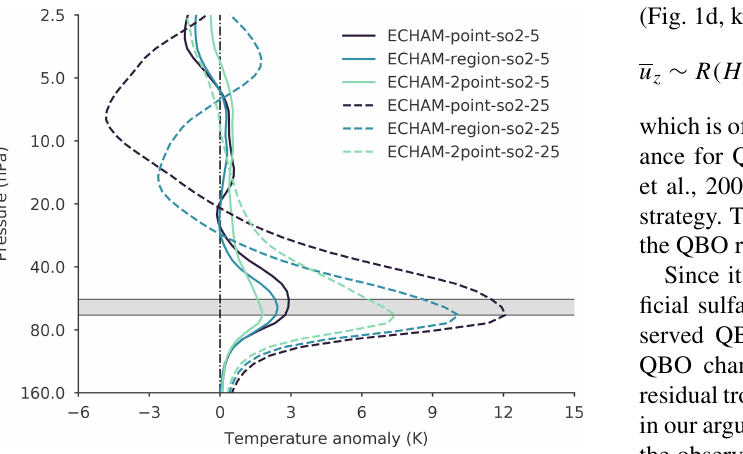
Figure 6. Vertical profile of the 5 ◦ N to 5 ◦ S mean temperature anomaly for the 5 and 25Tg ( S ) yr − 1 injections simulated with ECHAM. The horizontal grey bar marks the injection layer. The vertical dashed–dotted line marks a temperature anomaly of